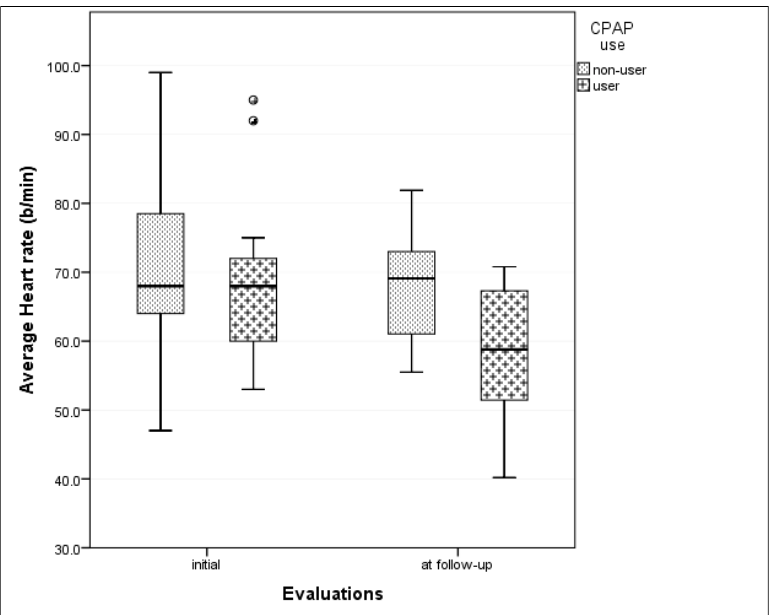
Figure 4. Change in mean heart rate according to CPAP usage between initial evaluation and follow-up. (CPAP—continuous positive airway pressure; small size circles in the graph represent outliers).